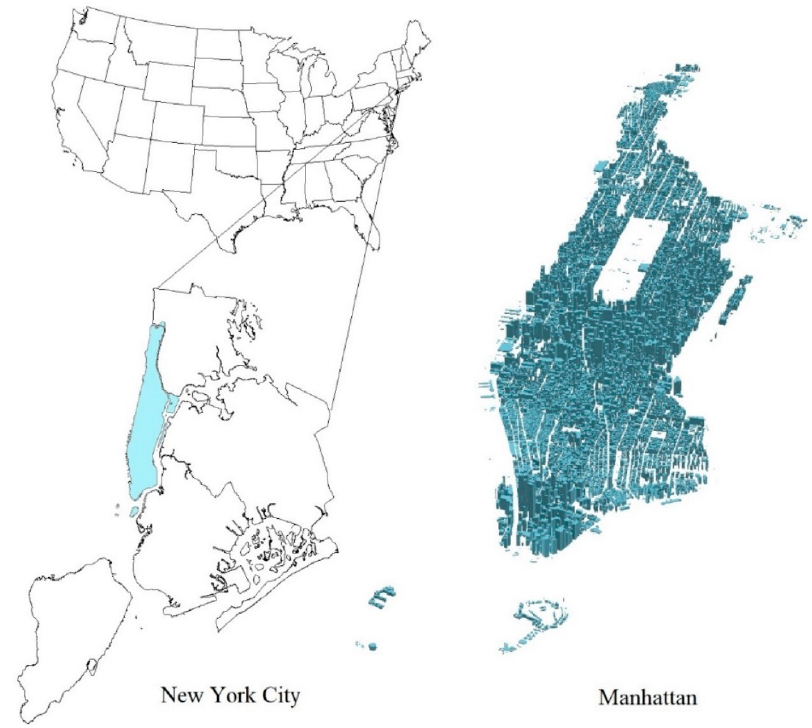
Figure 1. Study area: Manhattan, New York City, US